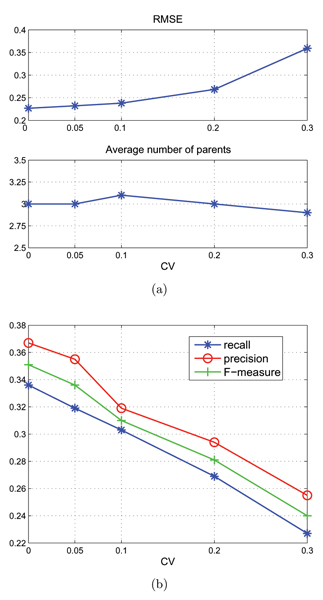
Robustness of the nonlinear model in the presence of noise. Plots of the RMSE and average number of parents (a), and recall, precision and F-measures (b) of the nonlinear model corresponding to α = 1.8, as a function of the CV of the noise. CV = 0 corresponds to the noiseless case.